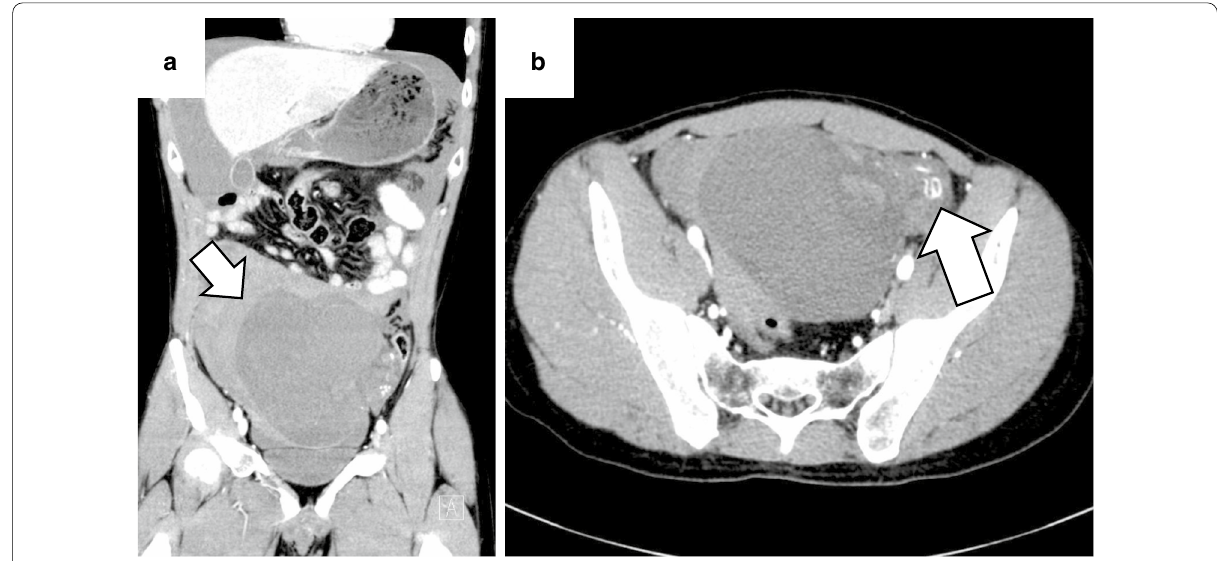
Fig. 1 a A large volume of high-density ascites in the abdominal cavity and a huge mass in the pelvis were observed. b The contrast enhancement effect of the mass was poor, and blood vessels were observed inside the mass